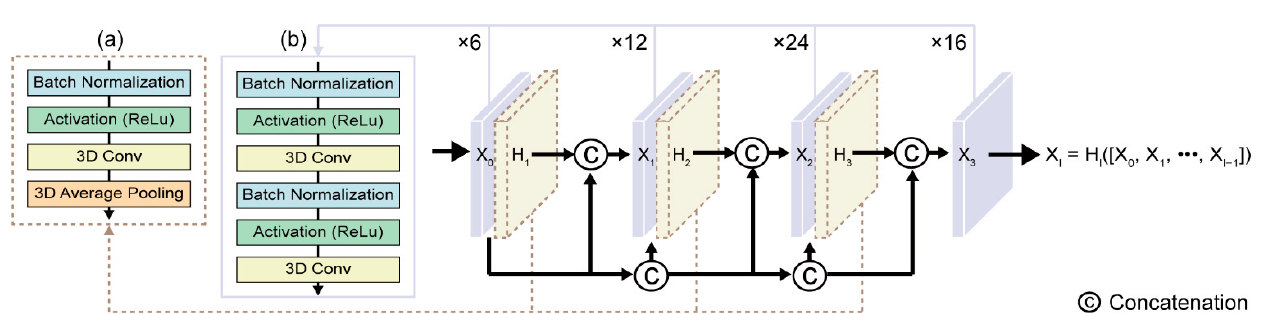
Figure 5. Detailed 3D dense-connection CNN architecture. ( a ) Three-dimensional transition layer; ( b ) three-dimensional dense block.